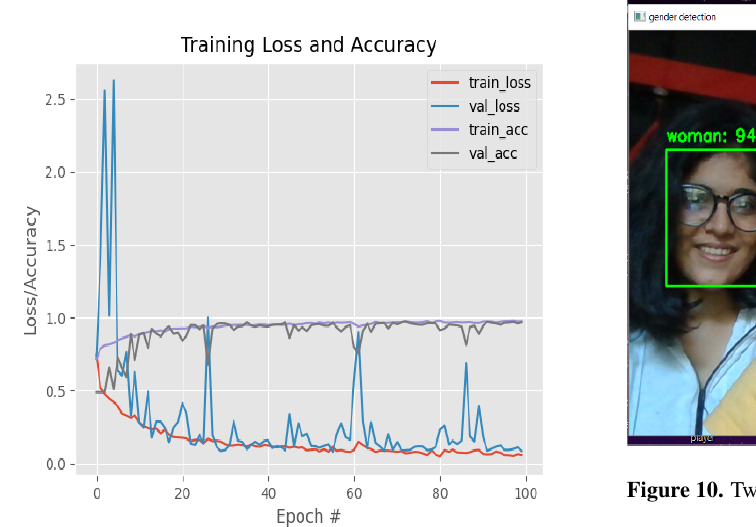
Figure 8. Loss Accuracy Overall